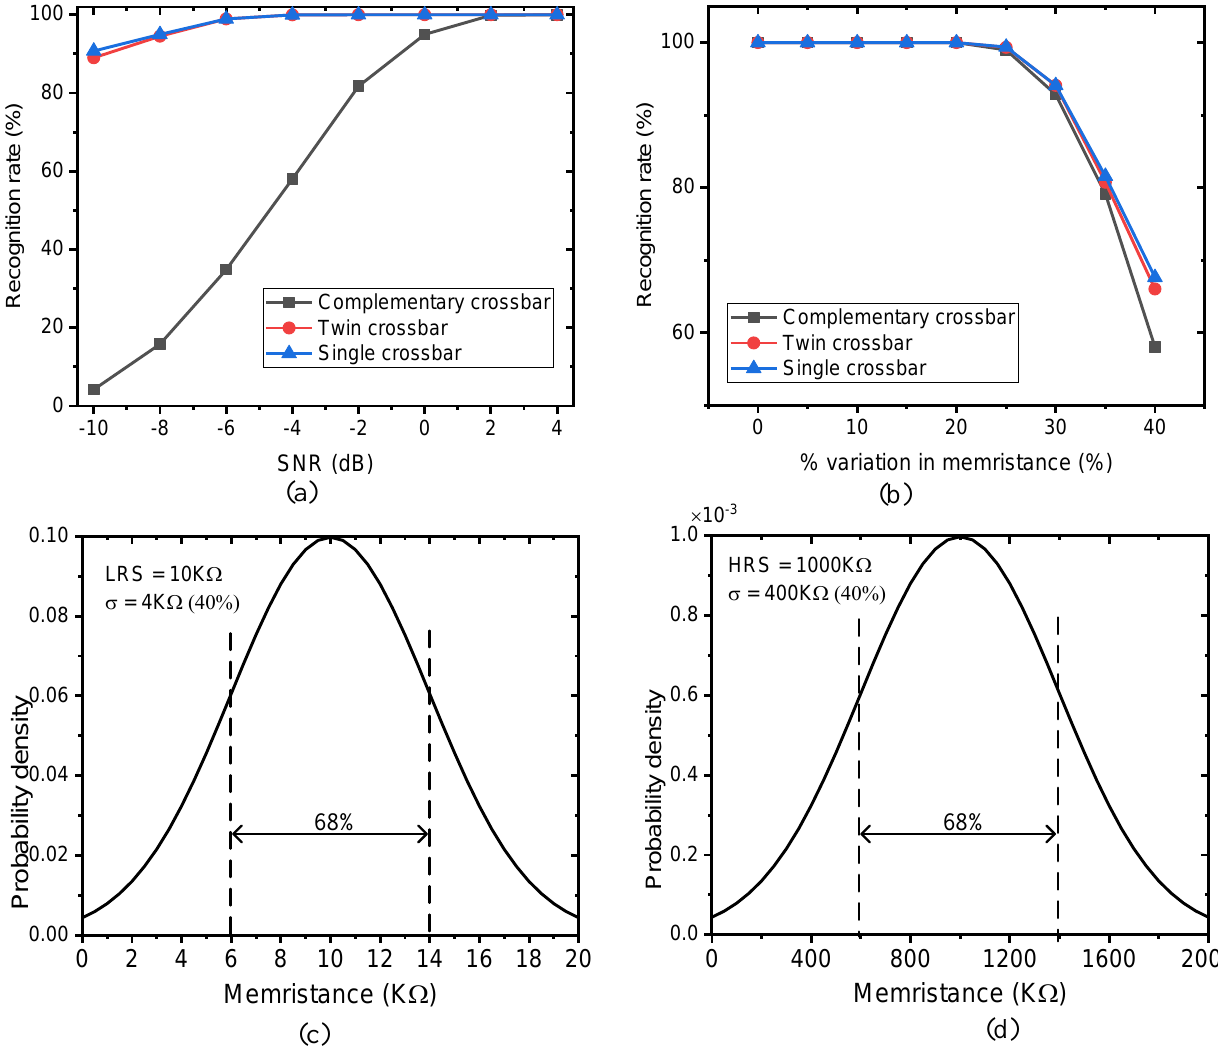
Figure 7. The recognition rates of three architectures: ( a ) images with Gaussian noise added in which the SNR was varied from − 10 to 4 dB; ( b ) variation in memristance of arrays; ( c ) statistical distribution of LRS; ( d ) statistical distribution of HRS.